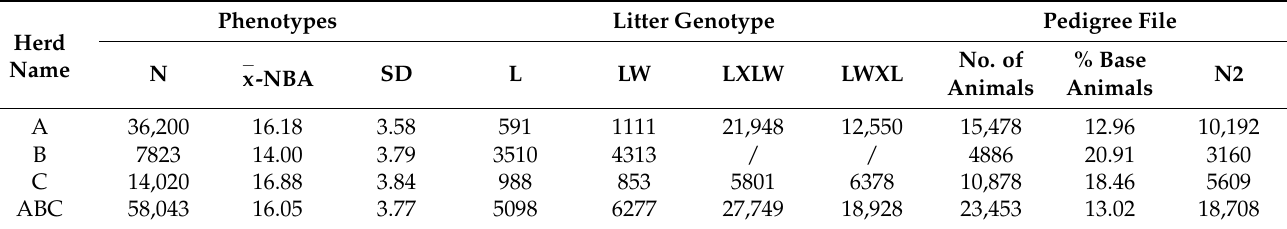
Table 1. Structure of data and pedigree files used in the